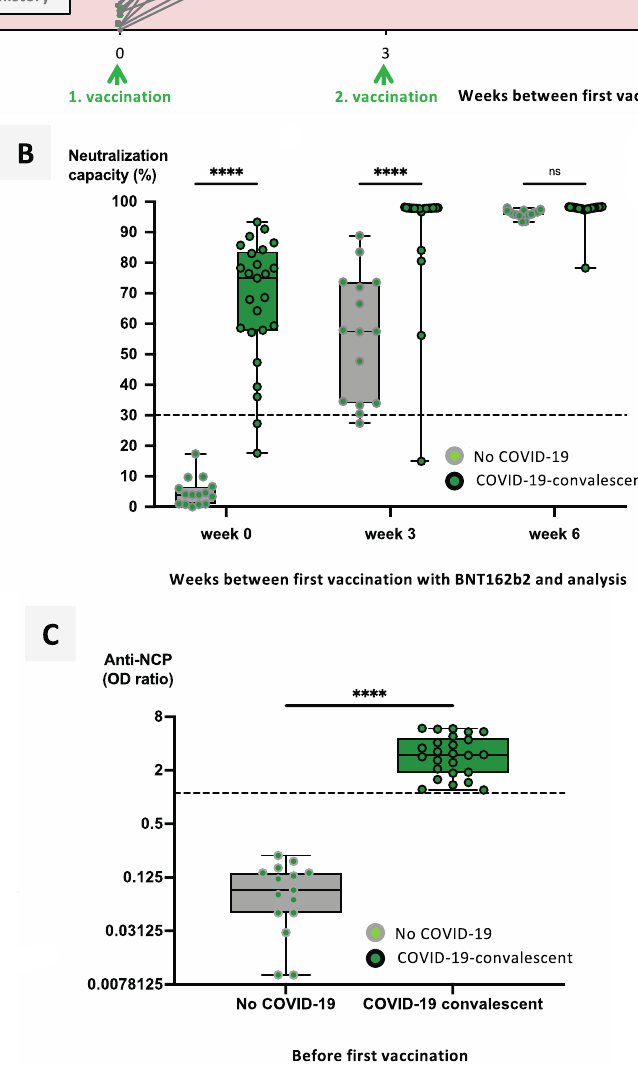
Figure 2. Impact of previous SARS-CoV-2 infection on the neutralizing capacity after vaccination with BNT162b2. Serum samples from 15 BNT162b2-vaccinated individuals without history of COVID-19 (cohort B) and 25 COVID-19-reconvales- cent BNT162b2-vaccinated individuals (cohort C) were collected at different timepoints after their first vaccination, as indicated. ( A ) Line graphs show individual courses for the neutralization capacity of ACE2 – RBD interaction. ( B ) Boxplots show median neutralization capacities at the time of first vaccination (0 weeks), second vaccination (3 weeks), and 3 weeks after second vaccination (6 weeks). ( C ) Boxplots show median anti-NCP IgG titers for COVID-19-naïve versus COVID-19- convalescent donors. ( D ) Boxplots show neutralization capacities against RBD variants as indicated in BNT162b2-vac-